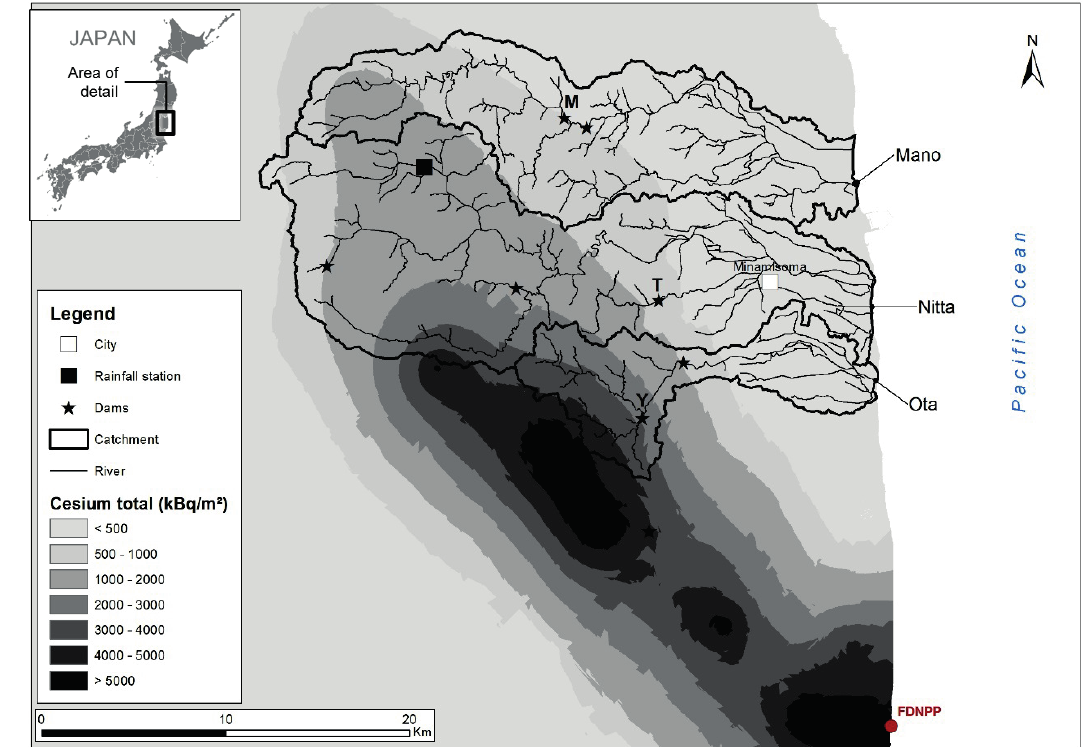
Fig. 1 134 Cs+ 137 Cs soil inventory recalculated to the date of 14 June 2011 based on MEXT data (2012) in the three study catchments (Mano, Nitta and Ota). FDNPP stands for Fukushima Dai-ichi Nuclear Power Plant, M for Mano dam, T for Takanokura dam and Y for Yokokawa dam. Sample